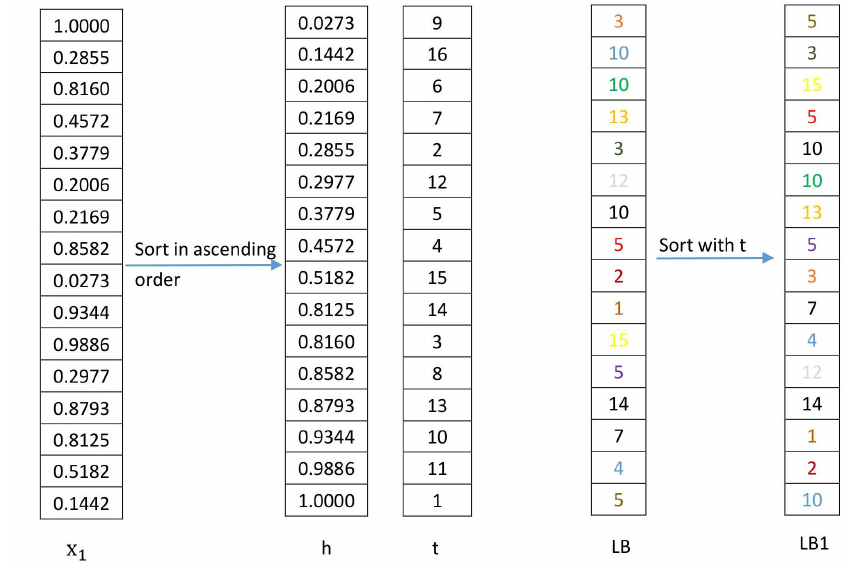
Figure 8. Example of pixel-plane